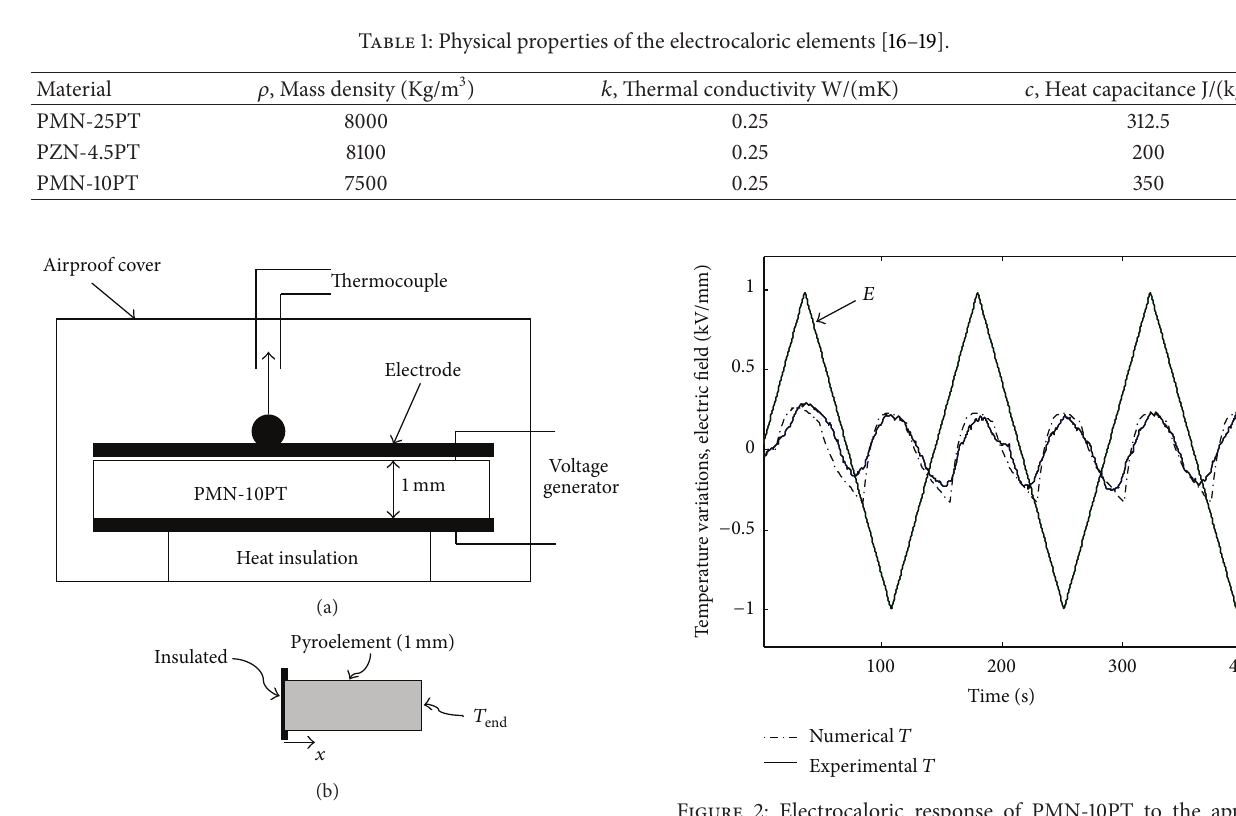
Figure 1: The sketch map of the EC element temperature measure- ment and physical model of electrocaloric element.